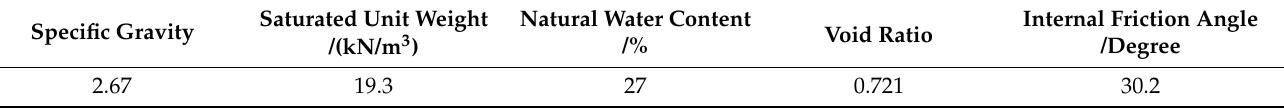
Figure 1. Grain-size distribution of the test soil. Table 1. Parameters of the test soil.